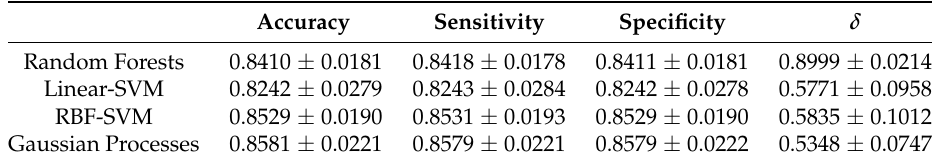
Figure 10. ROC curves for the different tests. Table 4. AUC, accuracy, sensitivity and specificity related to the bright-lesion detection on E-OPHTHA exudates database. Results were optimized to the best sensitivity/specificity trade-off.